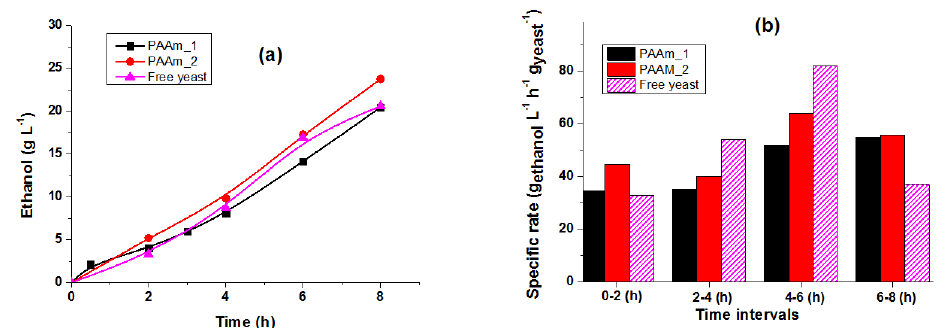
Figure 6. Fermentation of molasses solution with yeast immobilized on PAAm and free yeast for ethanol production: (a) ethanol concentration in time; (b) specific rate of fermentation.